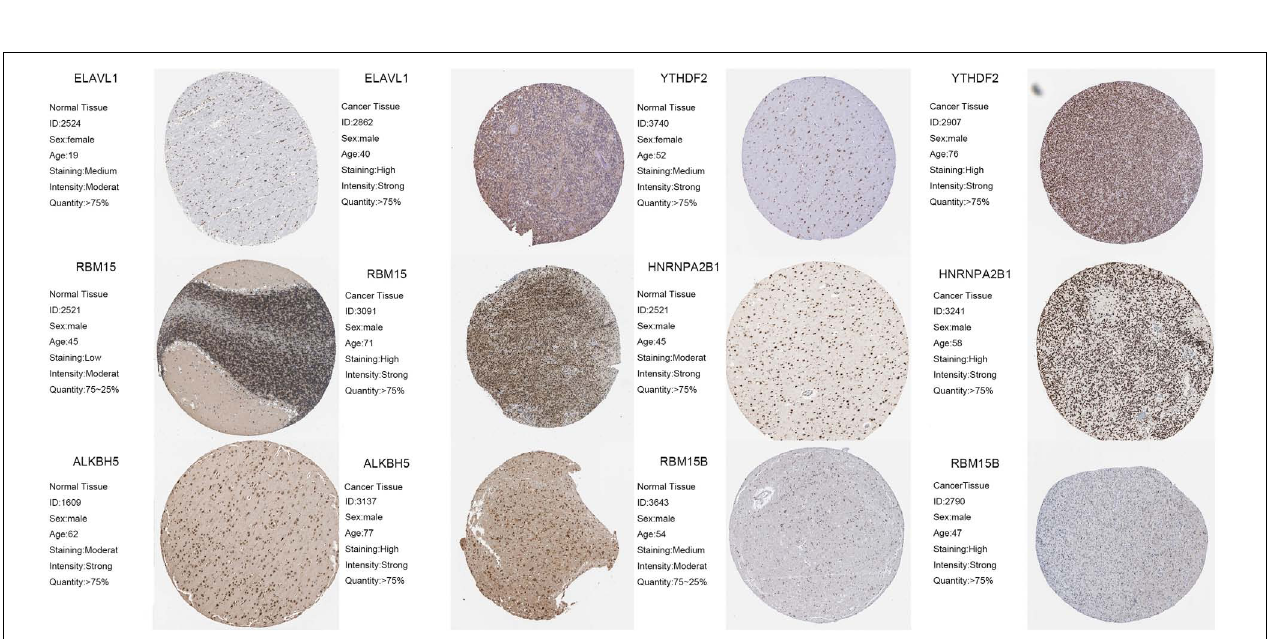
FIGURE 10 | The protein expression of m6A-related genes in normal tissues and tumor tissues.